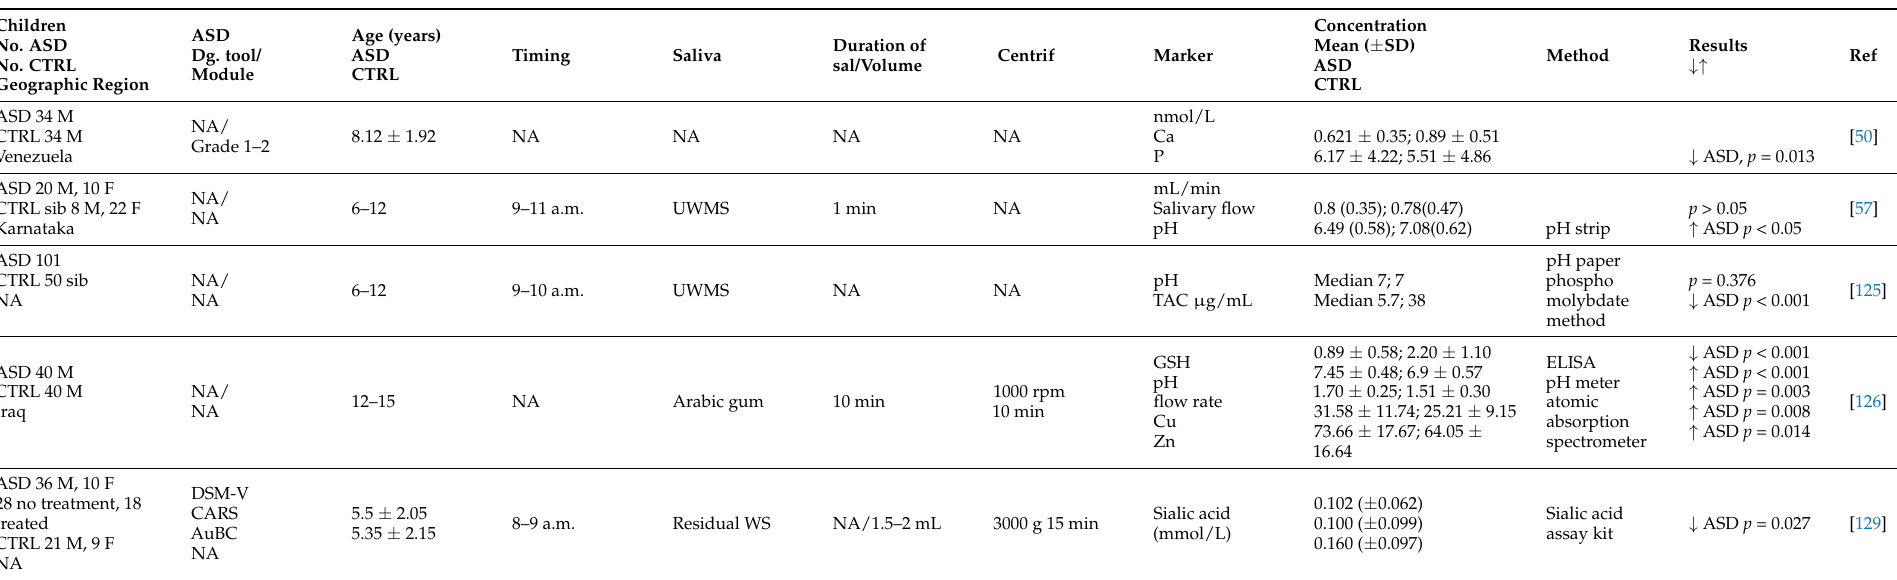
Table 4. Non-protein markers and parameters in saliva of autistic